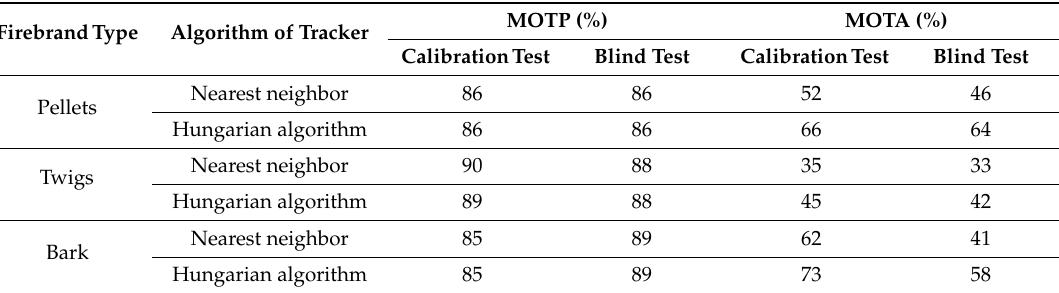
Table 4. Evaluating the quality of tracking algorithms.